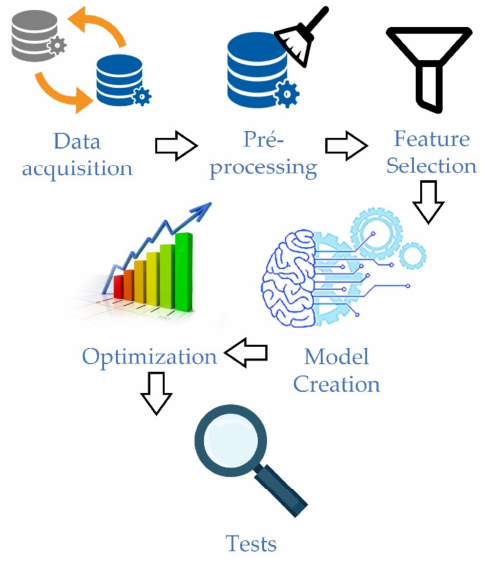
Figure 1. Flowchart of the methodology used.